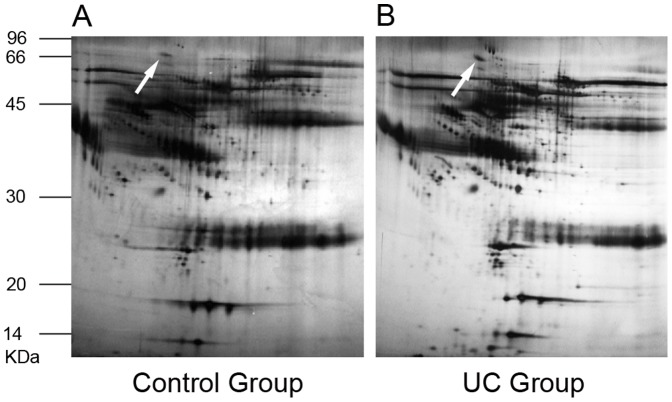
Total proteins from serum of normal control subjects and UC patients were analyzed by 2-DE.The proteins were separated by IEF (pH 3–10) and 10% SDS-PAGE and subsequently processed with silver staining. The spot marked with white arrow represented HSF2. A: Total proteins from serum of normal controls that were analyzed by 2-DE. B: Total proteins from serum of UC patients that were analyzed by 2-DE.